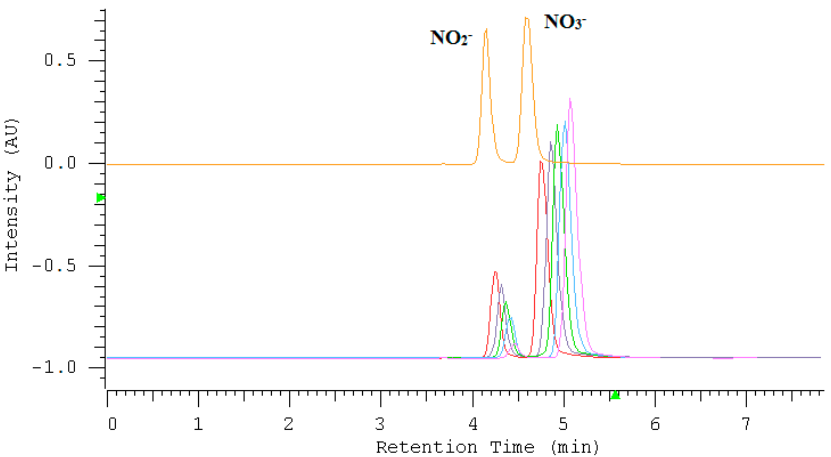
Figure 3. The overlapped chromatograms illustrating the peaks of nitrate/nitrite after oxidation reaction using potassium permanganate under acidic conditions. The upper chromatogram illustrates the separation of a mixture containing nitrate and nitrite for the identification of peaks.